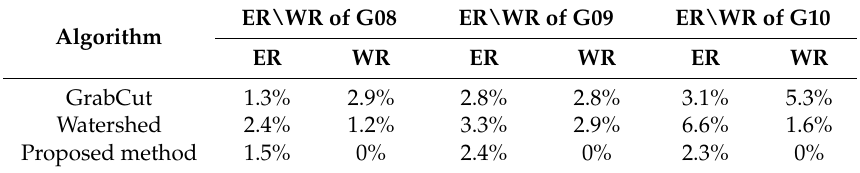
Table 6. Error ratio and work ratio comparison with interactive image segmentation algorithms.